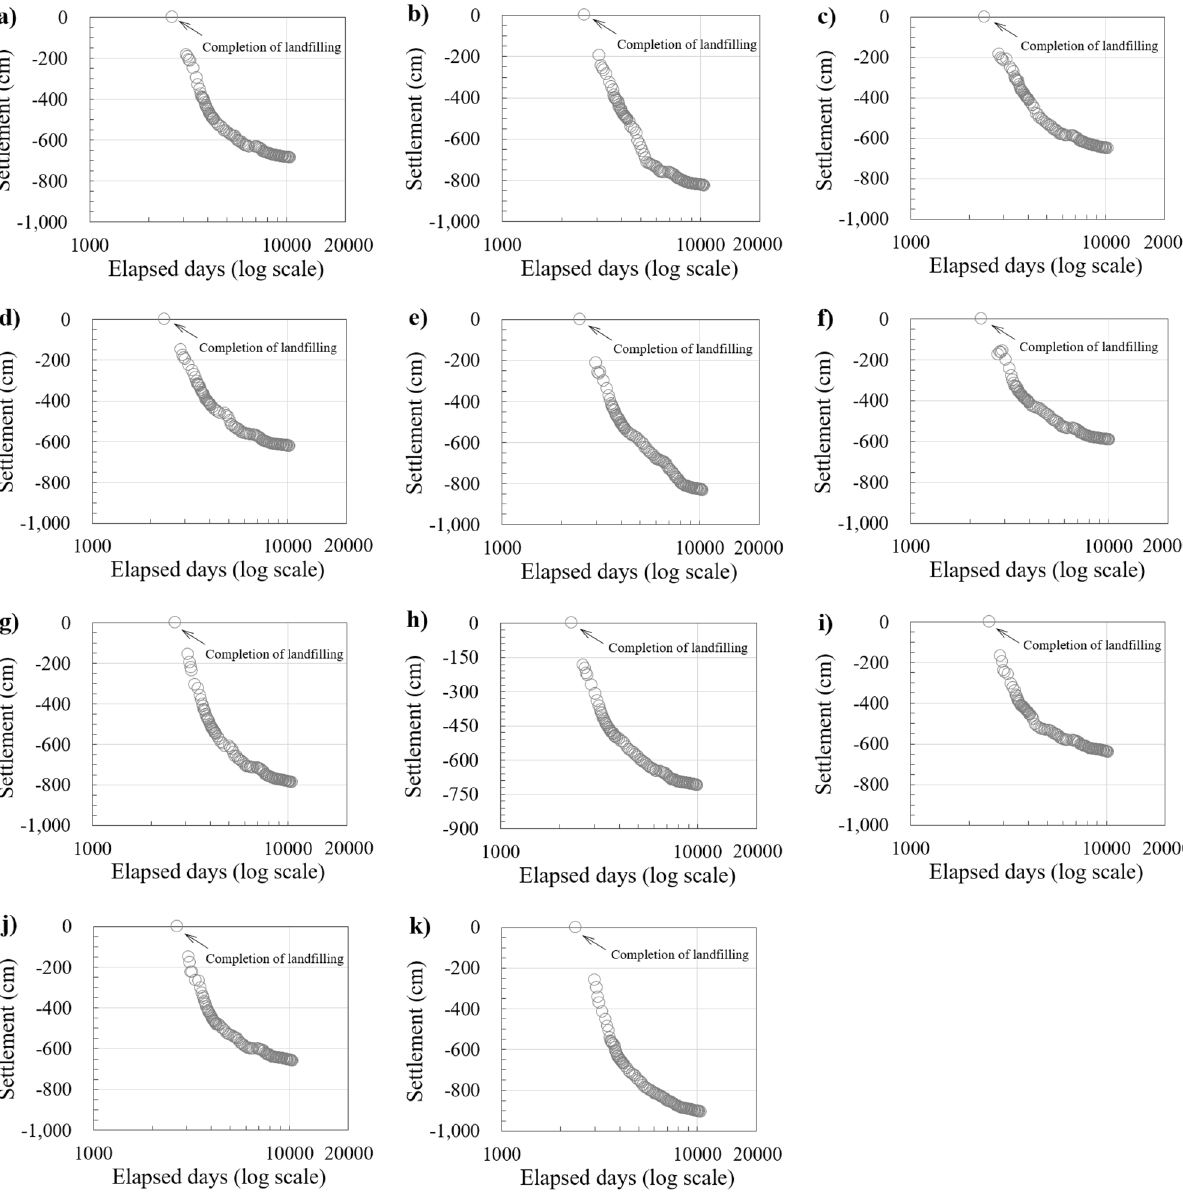
Figure 3. The waste settlement curves measured at each block of landfill #1 over 21 years after closure; ( a ) B block; ( b ) C block; ( c ) D block; ( d ) E block; ( e ) G block; ( f ) H block; ( g ) I block; ( h ) J block; ( i ) K block; ( j ) L block; ( k ) M